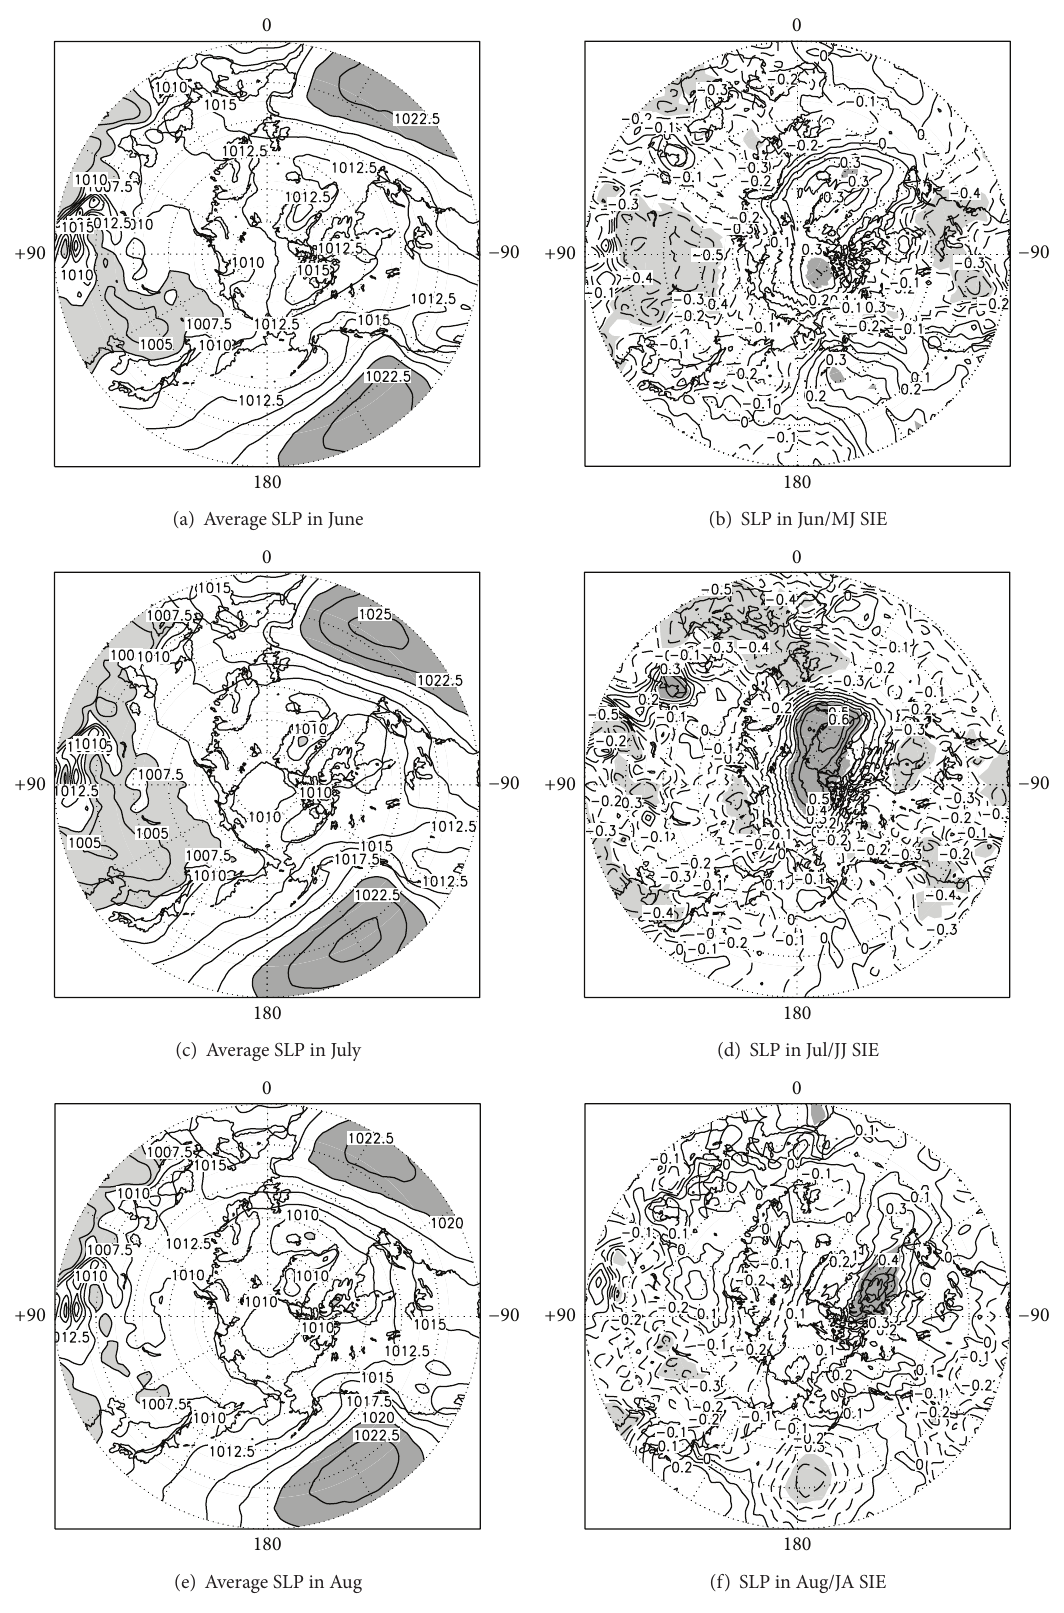
Figure 3: The monthly average sea level pressure (SLP) in June, July, and August for 1979–2012 and the correlation distribution between simultaneous monthly SLP and the monthly SIE differences over the north of 30 ∘ N: (a) average June SLP, (b) corr. between June SLP and MJ SIE, (c) average July SLP, (d) corr. between July SLP and JJ SIE, (e) average August SLP, and (f) corr. between August SLP and JA